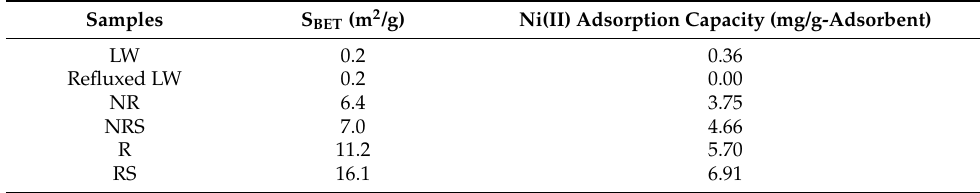
Table 2. BET surface area and Ni(II) adsorption capacity.